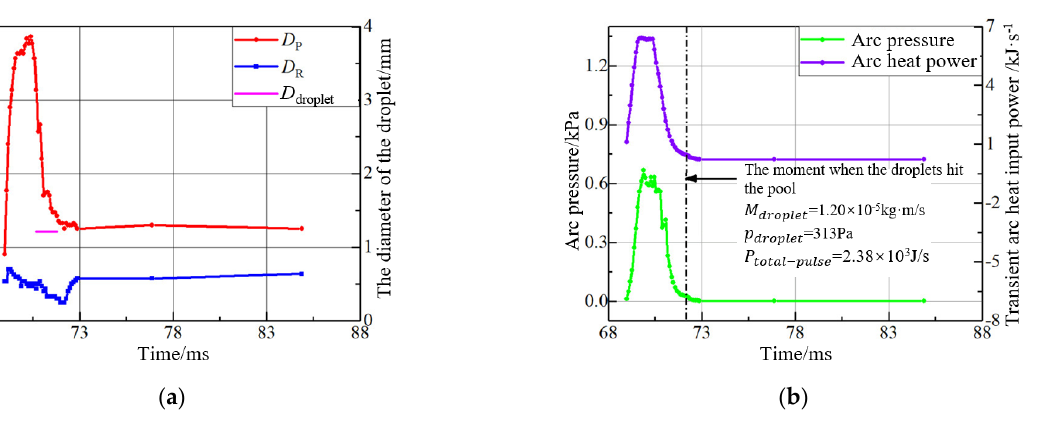
Figure 9. ( a ) The droplet and arc size in different times during a single pulse period ( I p = 485 A); ( b ) transient arc pressure and heat input power ( I p = 525 A).